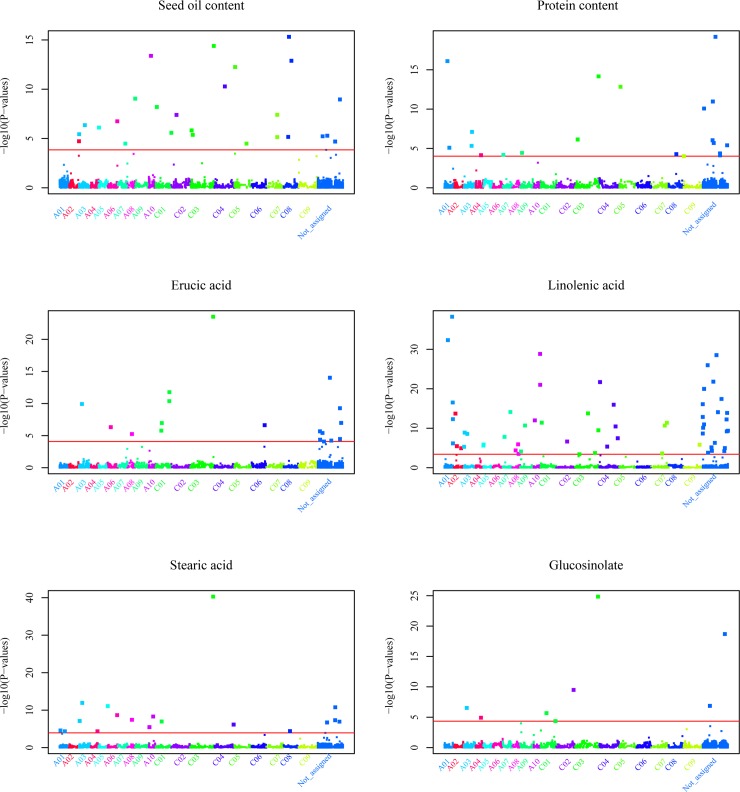
Manhattan plots based on composite interval QTL mapping for the six seed quality traits.The x-axis represents the corresponding physical position of each SNP of the 13,678 SNPs across the genome from chromosome A01 to A10 and C01 to C09. Those markers without unique alignment to the reference genome were arranged in the axis noted as “not assigned”. The Y-axis represents the corresponding false-discovery rate (FDR) of each QTL indicating the significance for QTL calling. The PVE, i.e. proportion of the phenotypic variance explained by each QTL, is listed in Table 2.